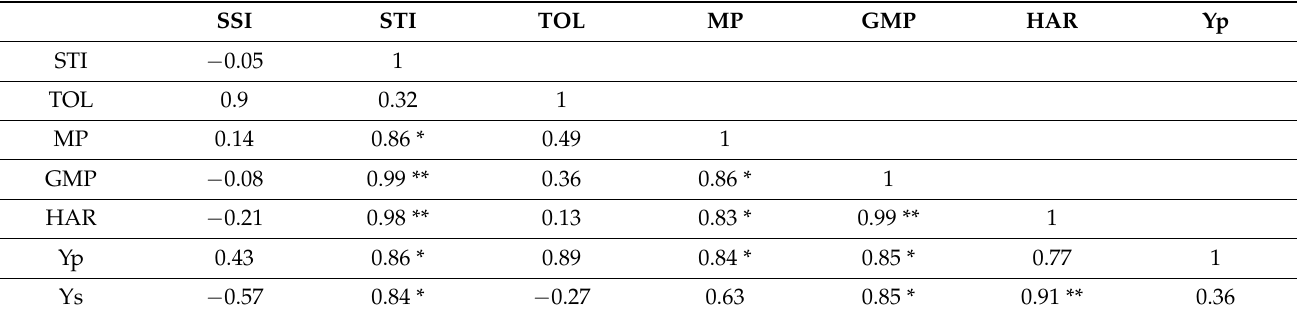
Table 5. The correlation coefficient between tolerance index and performance under moderate water-stress conditions.